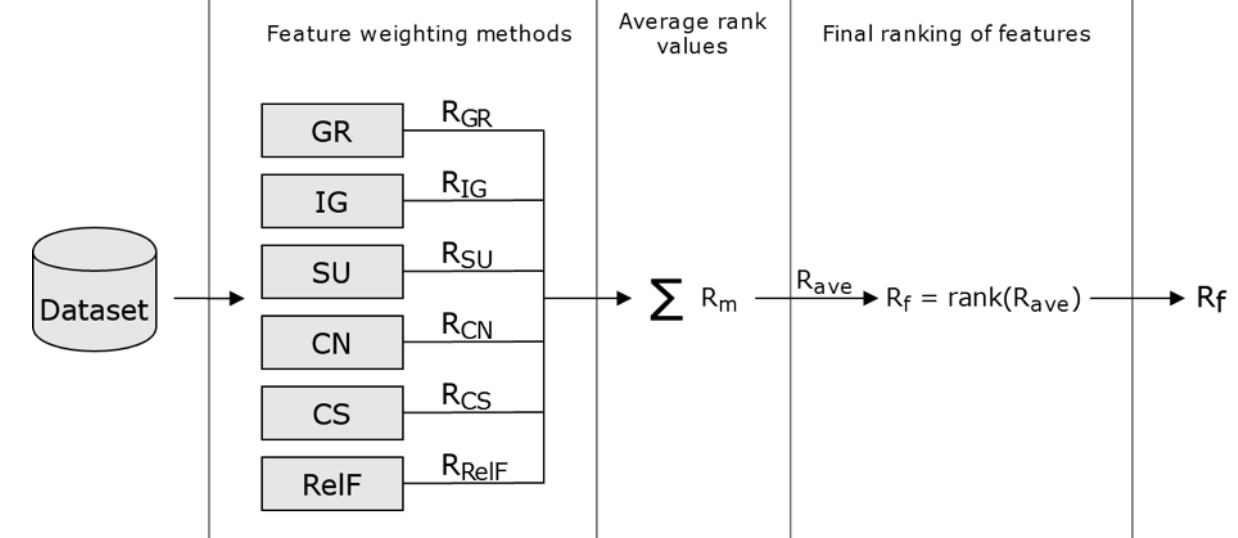
Figure 1. Flowchart illustrating the process of computing the final ranking of features.